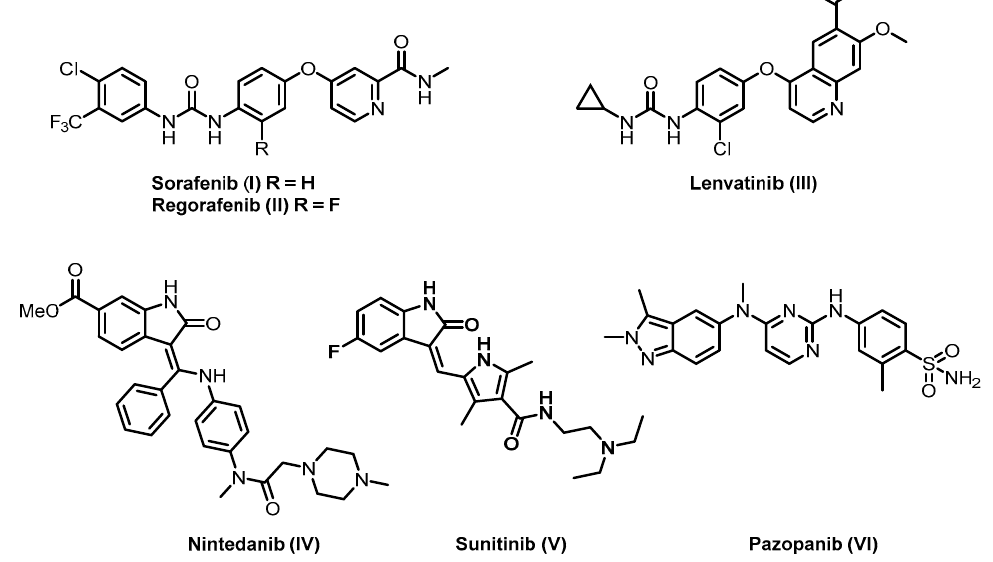
Figure 1. Examples of FDA-approved vascular endothelial growth factor receptor (VEGFR)-2